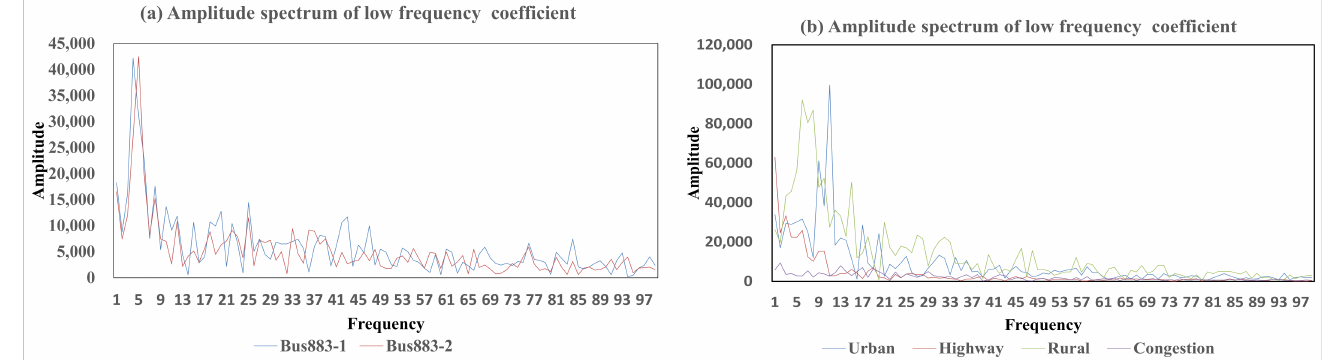
Figure 4. Amplitude spectrums of six driving